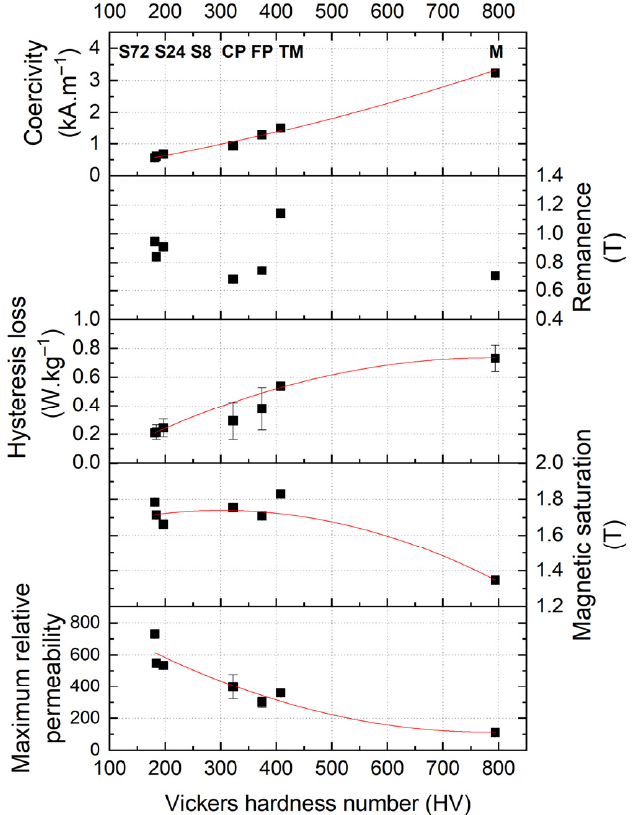
Figure 12. Relations between Vickers hardness and the main magnetic properties (coercivity, rema- nence, hysteresis loss, saturation, and maximum relative permeability) of the various microstructures of group C.